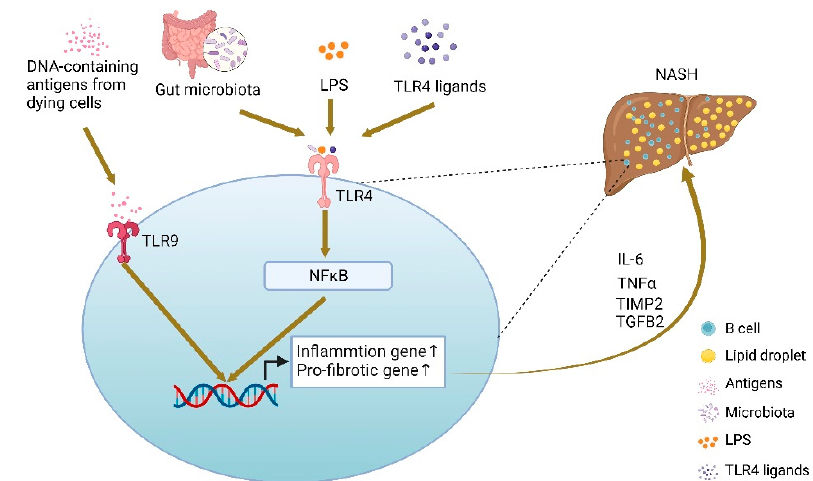
Figure 2. The proposed mechanism of activation of intrahepatic B cells during the disease progression of NASH. B-cell activation during NASH occurs simultaneously through the MyD88 and BCR signaling pathways upon encountering bacteria-derived antigens such as LPS, and bacterial metabolites, as well as through TLR9 which detects endogenous DNA-containing antigens released from dying cells [25], that induces the expression of inflammation and pro-fibrotic genes.